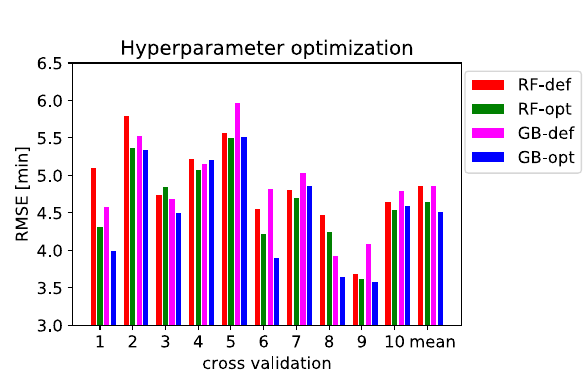
Fig. 4. Histogram of RMSE for the 10 fold cross-validation of default (red) and optimized (green) random forest as well as the default (magenta) and optimized (blue) gradient boosting algorithm, the fold number is indicated on the x -axis together with the mean of all